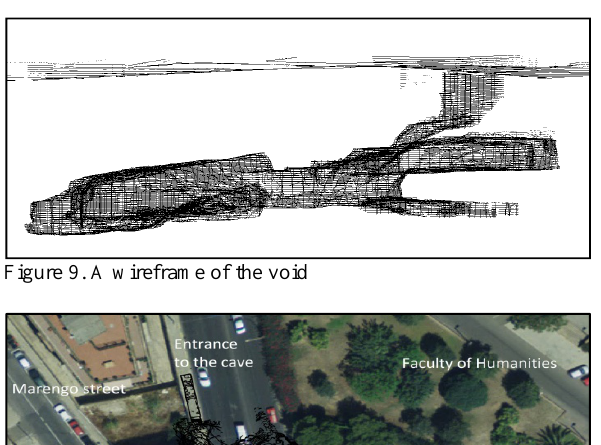
Figure 8. Global 3D Model: in the left side is shown Su Stiddiu cave